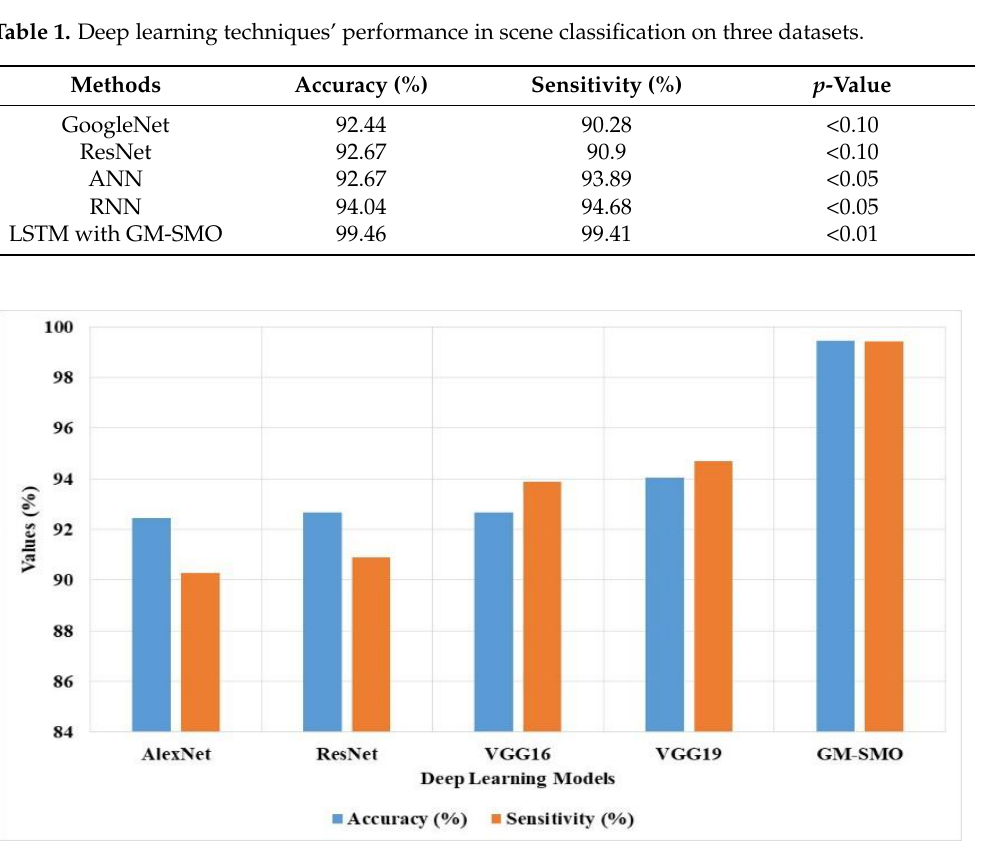
Figure 12. GM- SMO method’s accuracy and sensitivity compared with deep learning in three da- Figure 12. GM-SMO method’s accuracy and sensitivity compared with deep learning in three tasets.